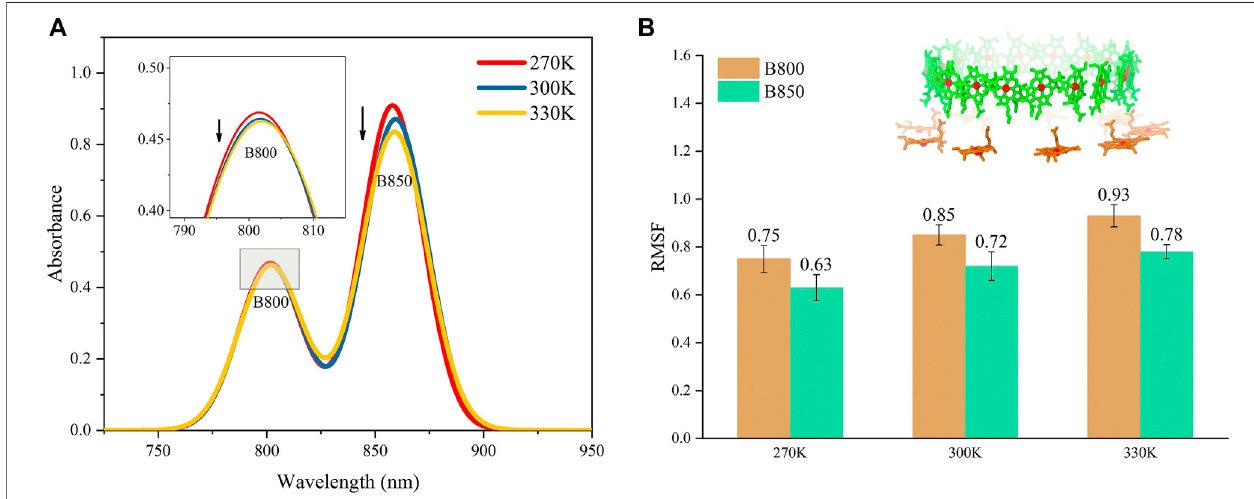
FIGURE2| AbsorptionspectrumsforLH2 (A) andaverageconformationalvariationsforB800andB850inLH2 (B) underdifferenttemperatures.Thestructuresfor B800 and B850 in LH2 were shown as the insert in (B) .